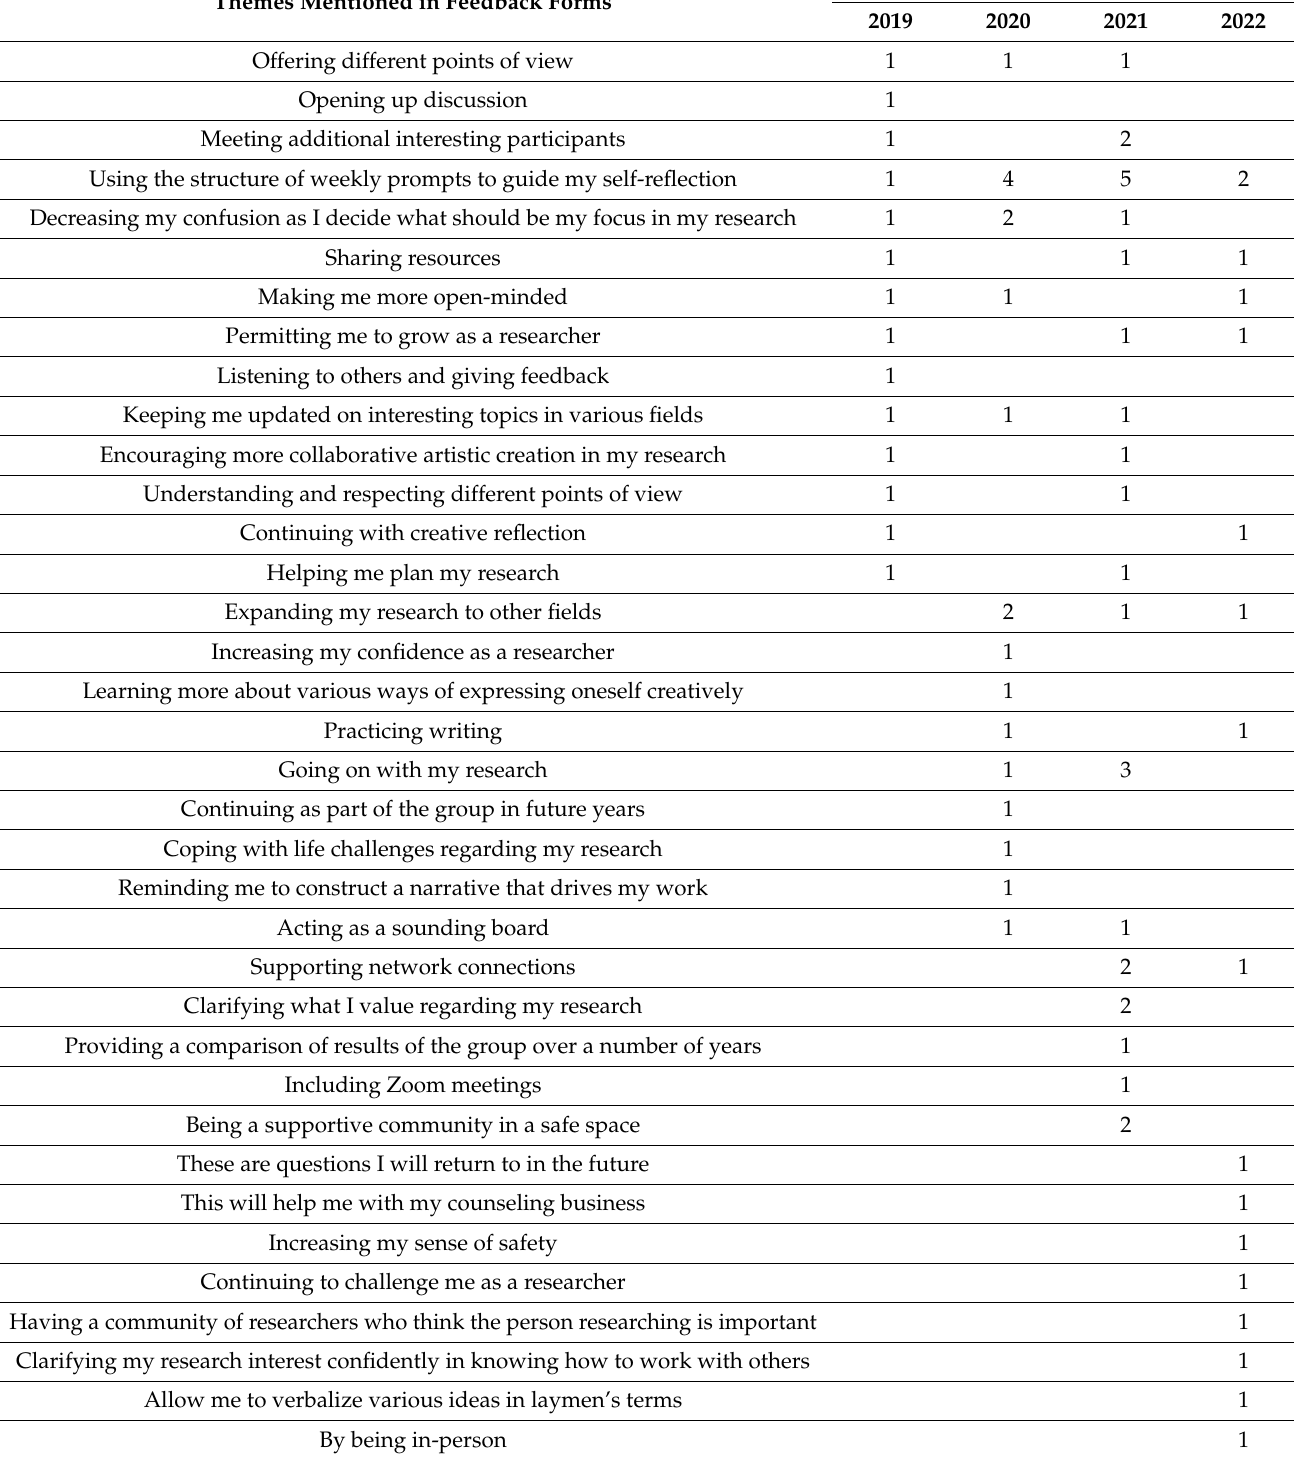
Table 4. Themes Mentioned in Responses Provided on the April Feedback Forms to “How Might the HeNReG be of Help to You in the Future?” for Each of the Four Most Recent Academic Years in Order of Receipt of Feedback Forms from